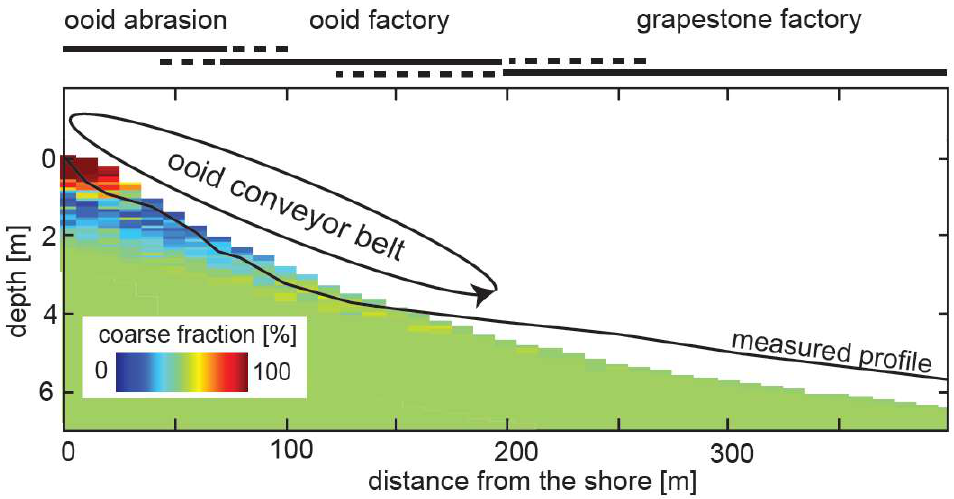
Figure 10. Conceptual model for the formation of ooid and grapestones. The ooid factory, where much ooid accretion occurs, is located in the upper shoreface, but outside the surf zone. Benthic microbial communities grow in these sediments, but are intermittently destroyed by high-energy events. Physical processes transport ooids in and out of the surf zone, where ooids are sorted, abraded and polished. The grapestone factory is located in the lower shoreface, and it overlaps with the ooid factory.